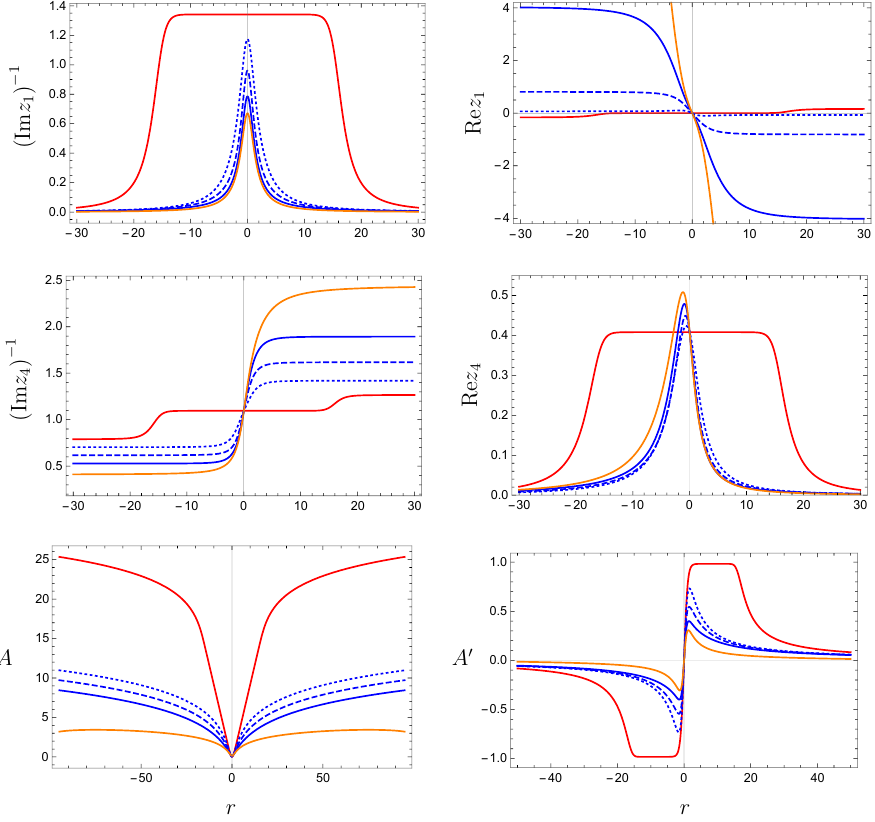
Figure 3 . Samples of regular flows within the SU(3) -invariant sector using the boundary condi- tions (3.25) for the complex scalar fields z